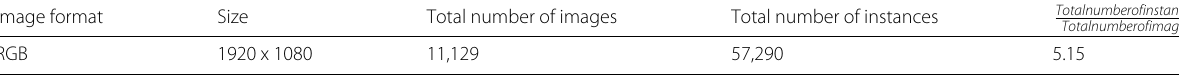
Table 1 Vehicle dataset information published in this study Image